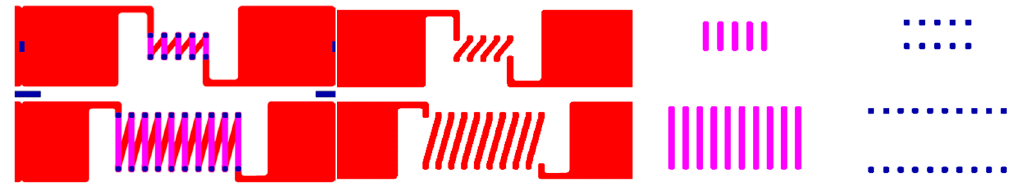
Figure 9. The design of the three-dimensional inductor.